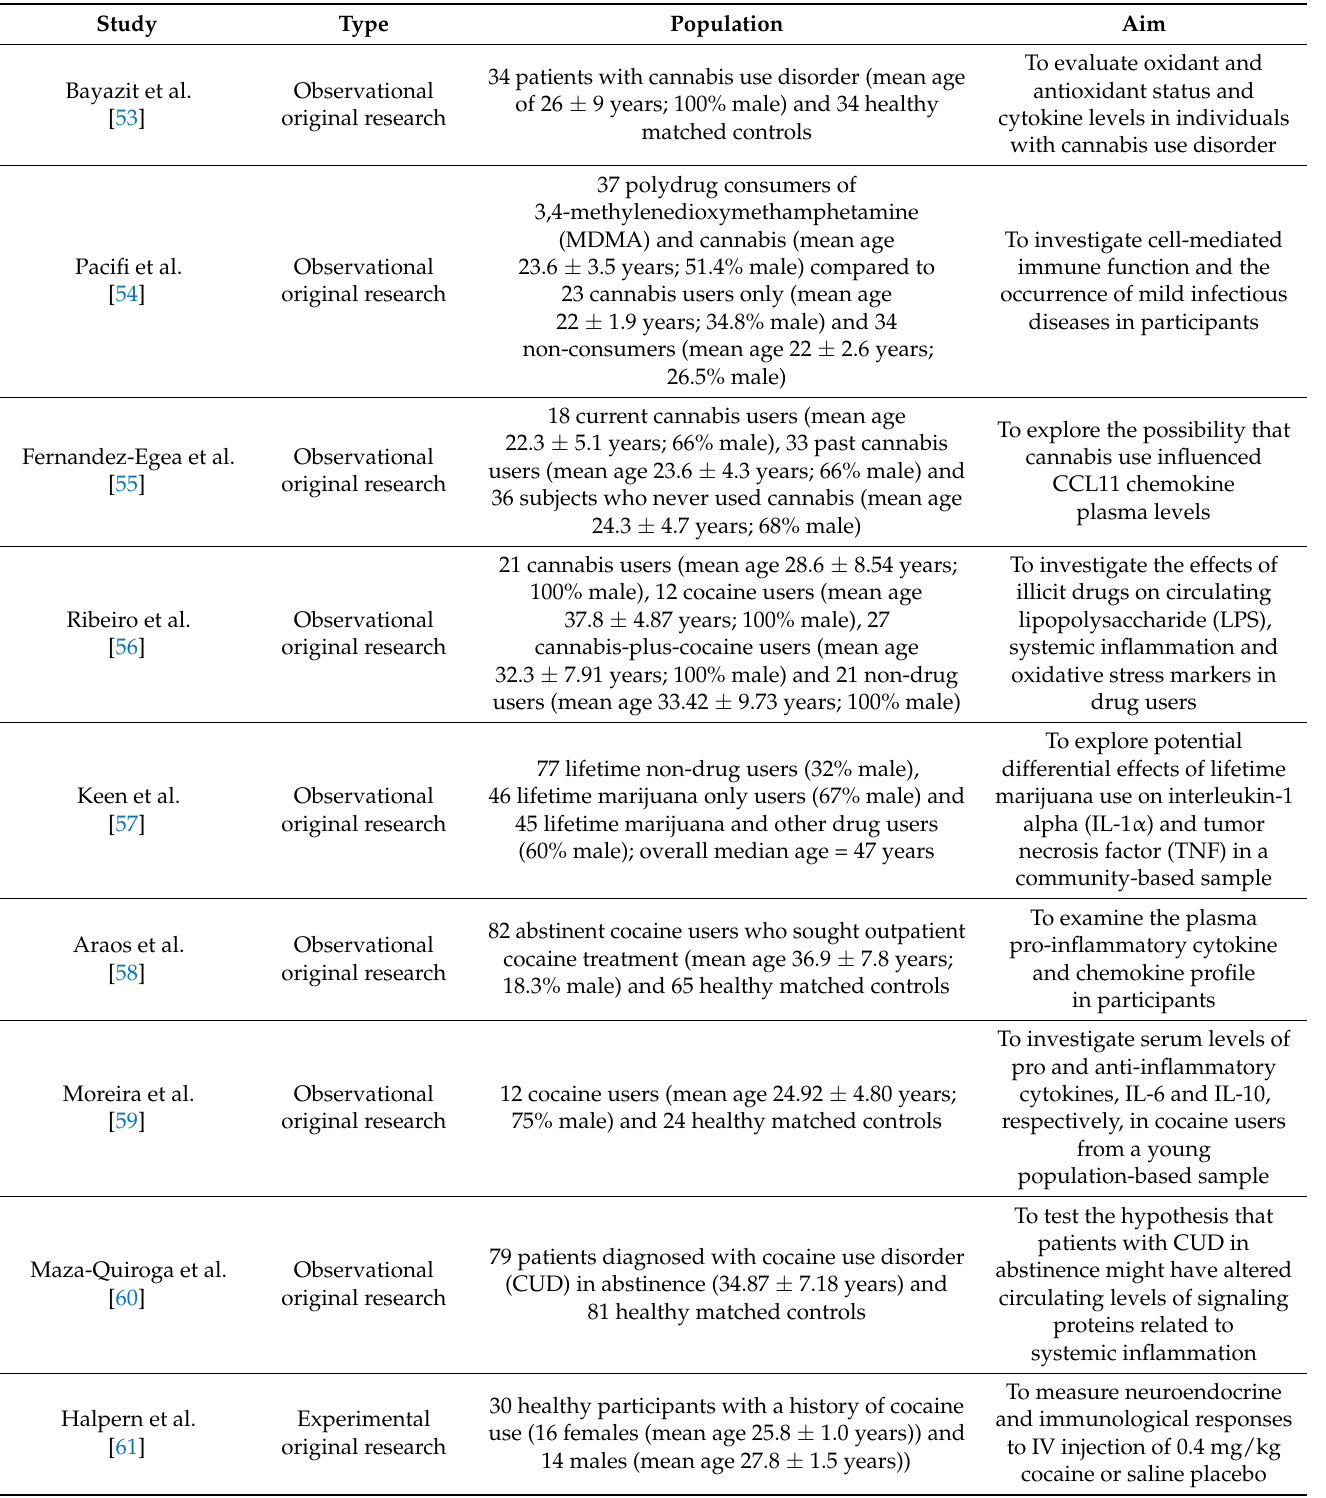
Table 2. Reviewed studies in substance use